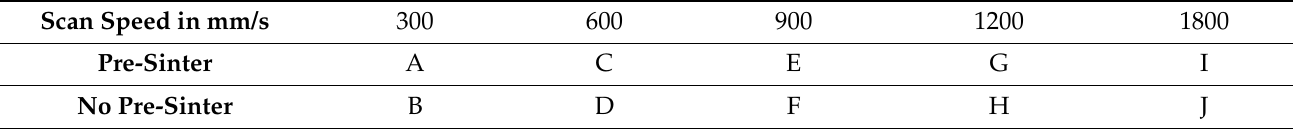
Table 4. Naming of sample groups based on contour scan